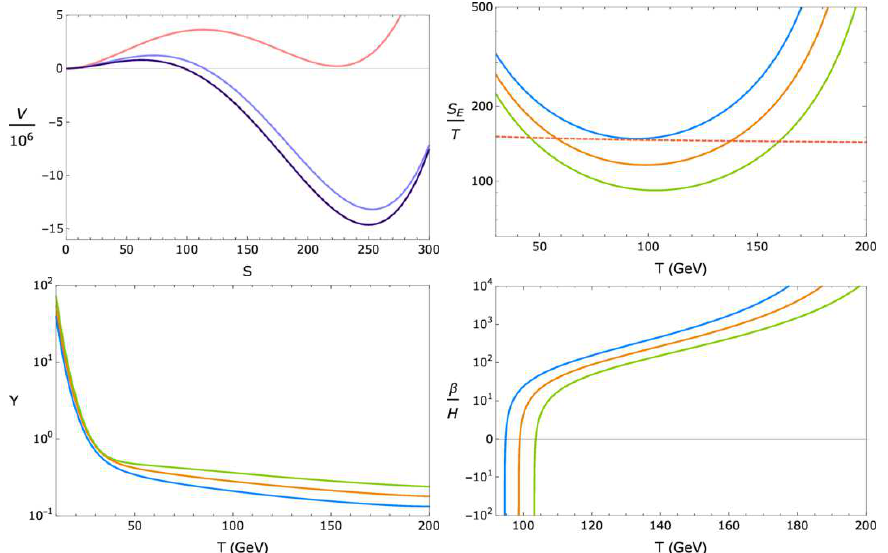
Figure 6 . Top left: evolution of the singlet potential with temperature (top left). The pink curve denotes the potential at the critical temperature, dark blue at the nucleation temperature and light blue at zero temperature. Top right: the evolution of the effective action, bottom left: Υ, bottom right: the speed of the phase transition. All with temperature for v s = 260 , α = 0 . 6 and Λ = 115 , 125 , 135 for the green, orange and blue lines { }